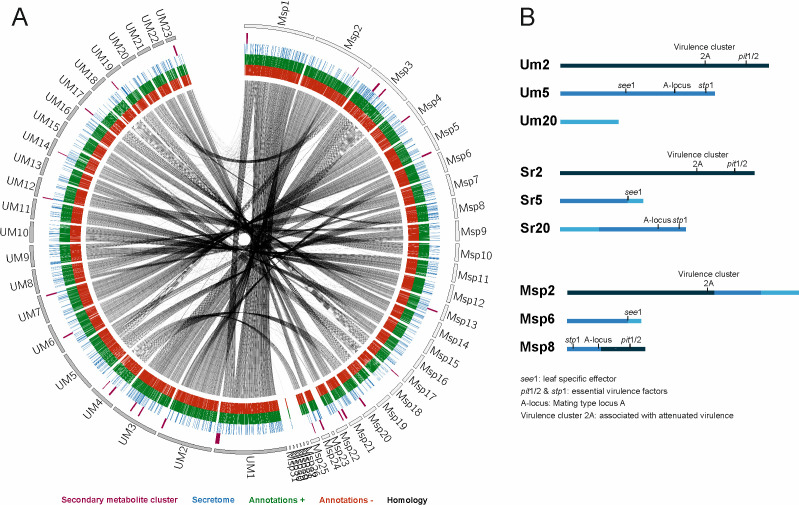
Circos comparison of MbA and U. maydis chromosome structure (A).We highlighted potential secondary metabolite clusters, secreted proteins, and gene predictions on both strands (±). (B) Homology-based comparisons identified three chromosomal recombination events, which affects the MbA contigs 2, 6, and 8.